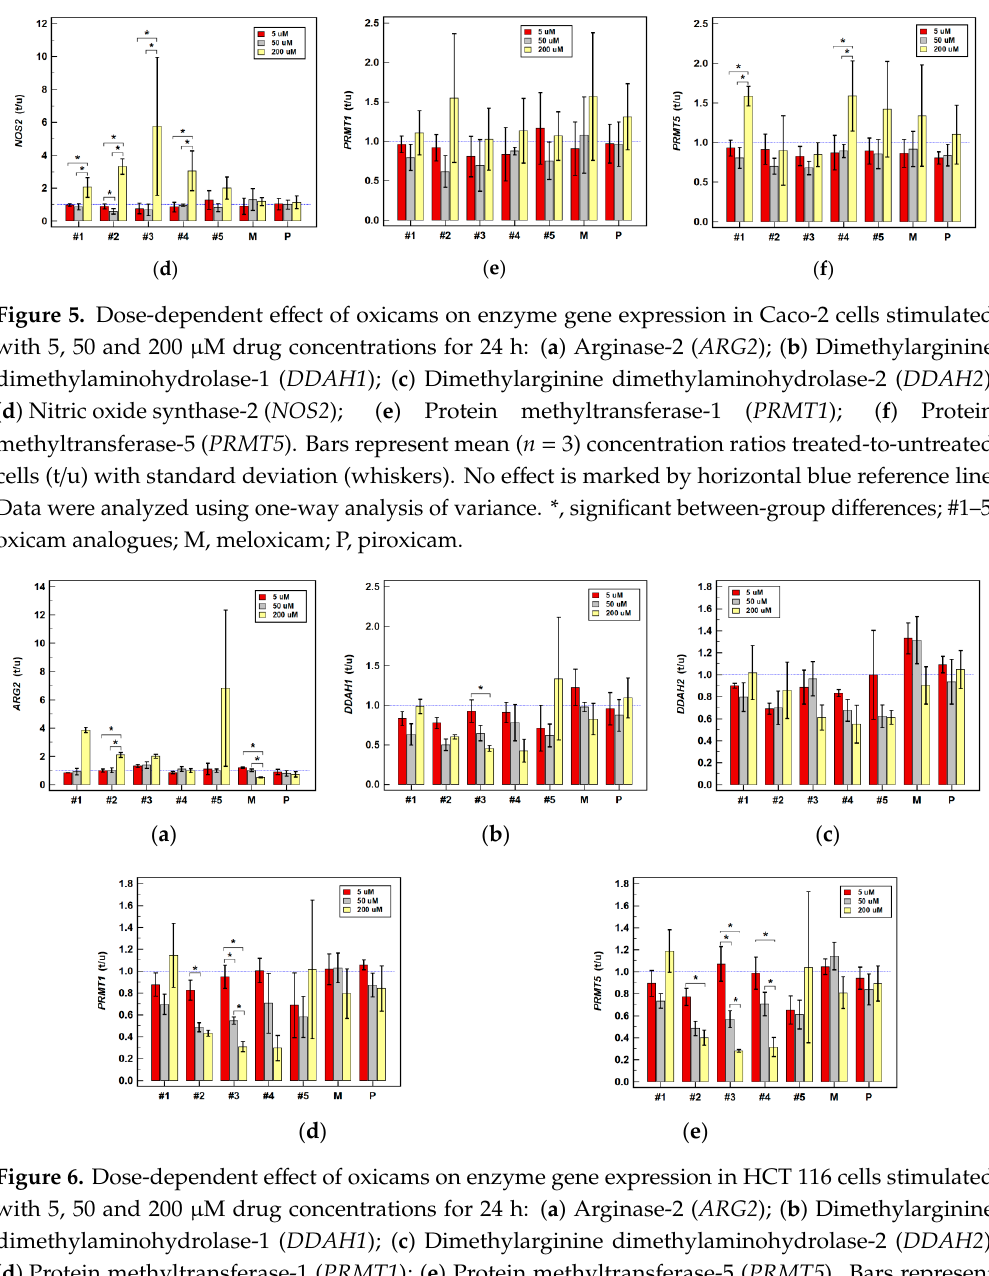
Figure 6. Dose-dependent effect of oxicams on enzyme gene expression in HCT 116 cells stimulated with 5, 50 and 200 µM drug concentrations for 24 h: ( a ) Arginase-2 ( ARG2 ); ( b ) Dimethylarginine dimethylaminohydrolase-1 ( DDAH1 ); ( c ) Dimethylarginine dimethylaminohydrolase-2 ( DDAH2 ); ( d ) Protein methyltransferase-1 ( PRMT1 ); ( e ) Protein methyltransferase-5 ( PRMT5 ). Bars represent mean ( n = 3) concentration ratios treated-to-untreated cells (t/u) with standard deviation (whiskers). No effect is marked by horizontal blue reference line. Data were analyzed using one-way analysis of variance. *, significant between-group differences; #1–5, oxicam analogues; M, meloxicam; P, piroxicam.